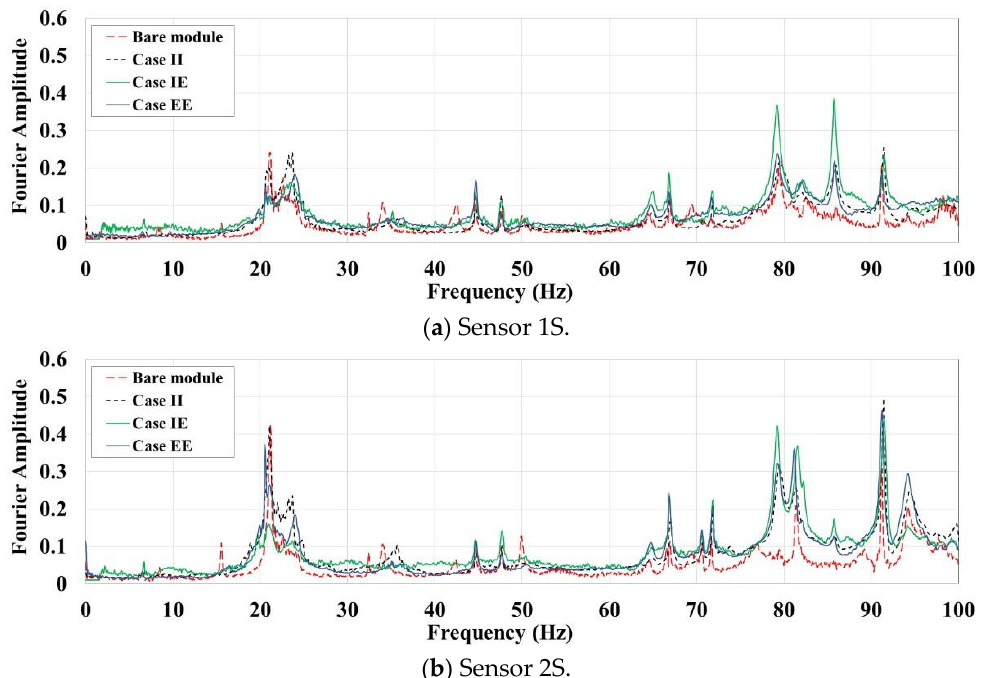
Figure 10. Averaged FFT plots for the S-oriented sensors. ( a ) Sensor 1S; ( b ) Sensor 2S.